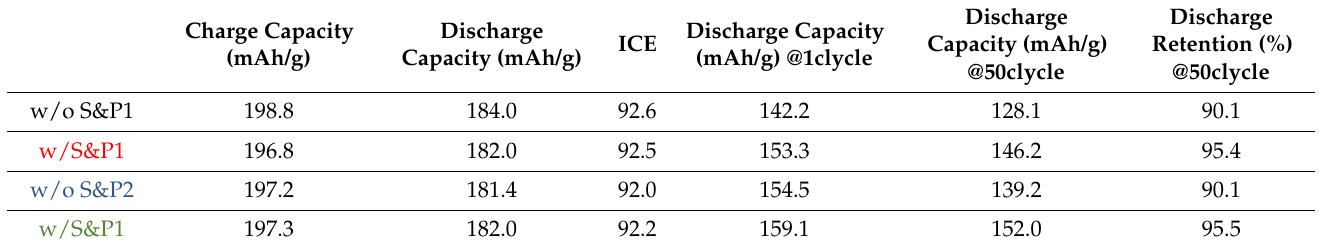
Figure 3. ( a ) Electrochemical performance of without S&P1, with S&P1, without S&P2, and with S&P2 in evaluation of lithium-ion battery (LIBs) for the formation (initial charge − discharge) voltage profiles at 0.1C rate between 2.75 and 4.3 V at 30 ◦ C. ( b ) The following 50 cycle performance at 5C at 30 ◦ C. ( c ) Coulombic efficiency of the 50 cycles with charge and discharge C-rates of 5C. Table 1. Formation charge capacity, discharge capacity, and initial coulombic efficiency (ICE) of without S&P1, with S&P1, without S&P2, and with S&P2 at 0.1C at 30 ◦ C. Cycle charge and discharge capacity of 1 cycle, 50 cycle, and capacity retention after 50 cycle at